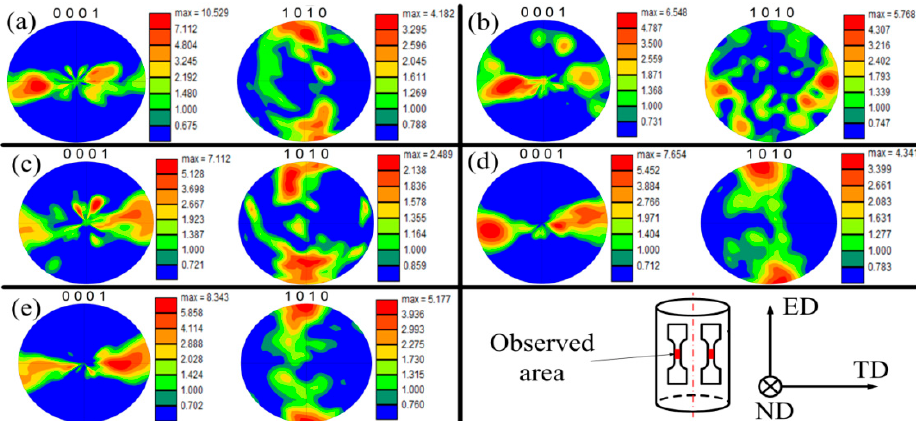
Figure 7. Texture evolution of the {0001} and {1010} in fractured AZ31 samples in the ND plane for the different tested configurations: ( a ) undeformed material, ( b ) RT, ( c ) OH, ( d ) AC, and ( e ) EA and the sample orientation respect to the main directions.